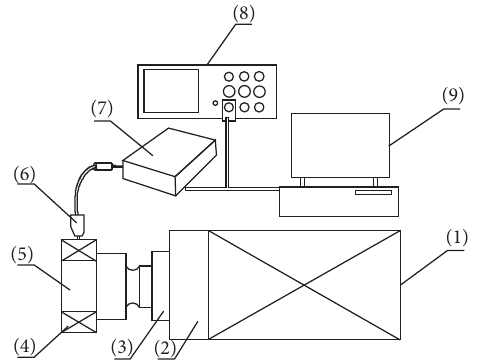
Figure 1: Diagram of experimental system. (1) Motor, (2) driver, (3) principal axis, (4) bearing, (5) core axes, (6) acceleration sensor, (7) acquisition data card, (8) oscilloscope, and (9) computer.